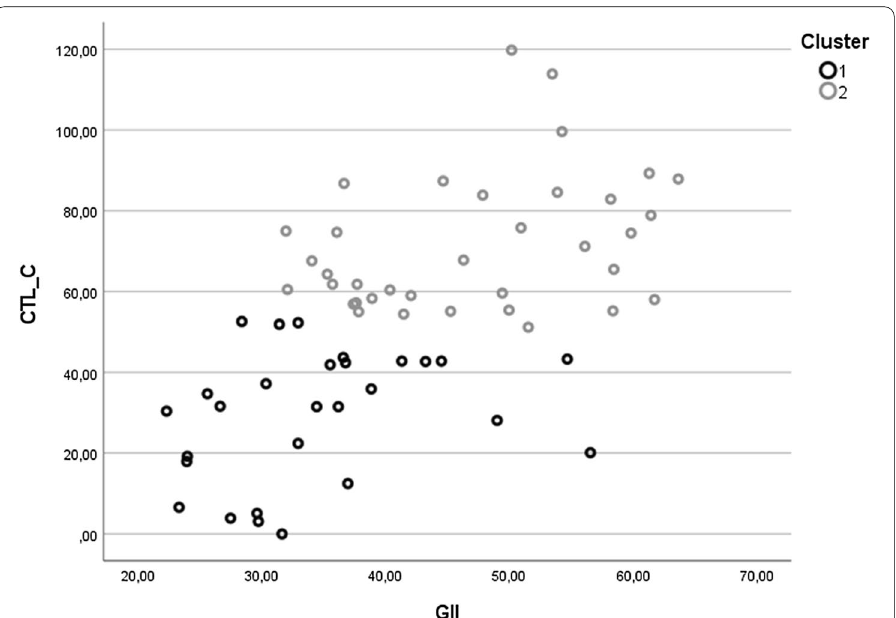
Fig. 1 Clusters of cultural tightness–looseness and innovativeness. Source: Authors’ compilation